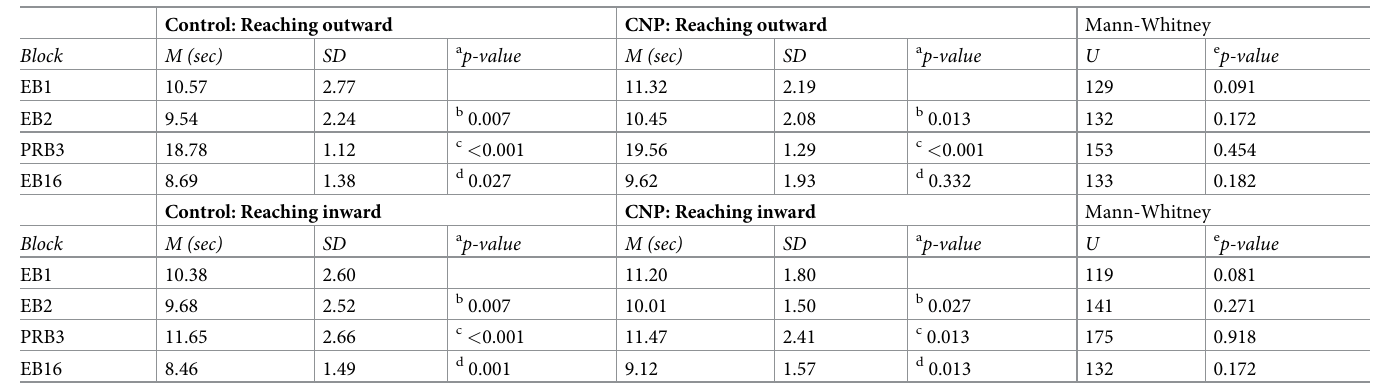
Table 5. Explicit motor learning within group and between group